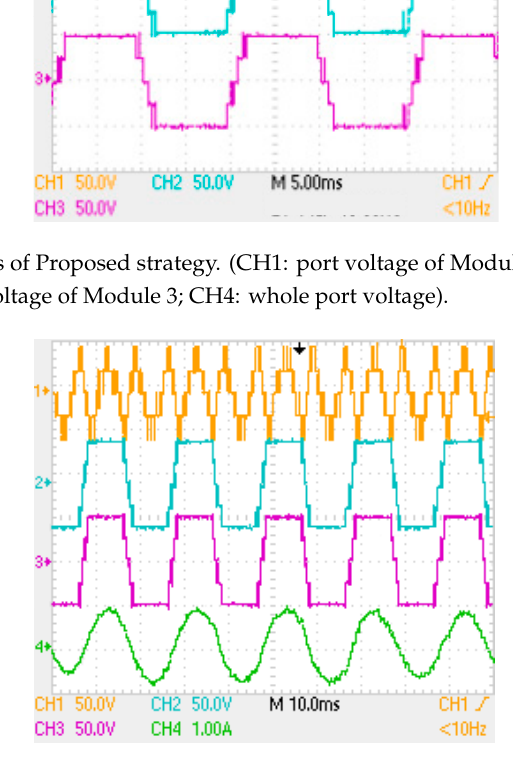
Figure 17. DC-port fault when SPM applied. (CH1: port voltage of Module 1; CH2: port voltage of Module 2; CH3: port voltage of Module 3; CH4: AC-link current of cascaded modules.).